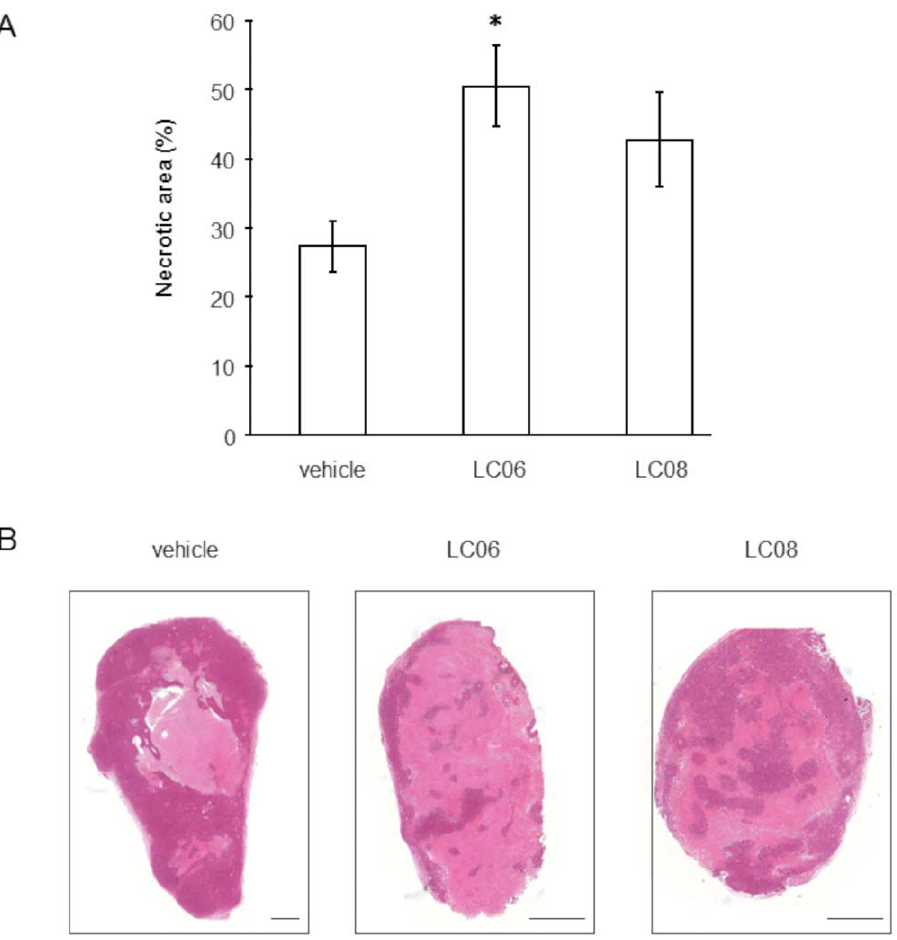
Figure 3. Tumor necrosis in LC06 and LC08 treated Colo205 tumors. ( A ) Quantitative image analysis shows 27% of necrotic area in vehicle treated, 51% in LC06 treated and 43% in LC08 treated tumors (n=5, *p , 0.05 compared to control, Student’s t-test). Results are expressed as mean 6 SEM. Two independent experiments were performed to confirm the results. ( B ) Representative mosaic images (10x) of vehicle, LC06 or LC08 treatments. Scale bar represents 1.3 mm.